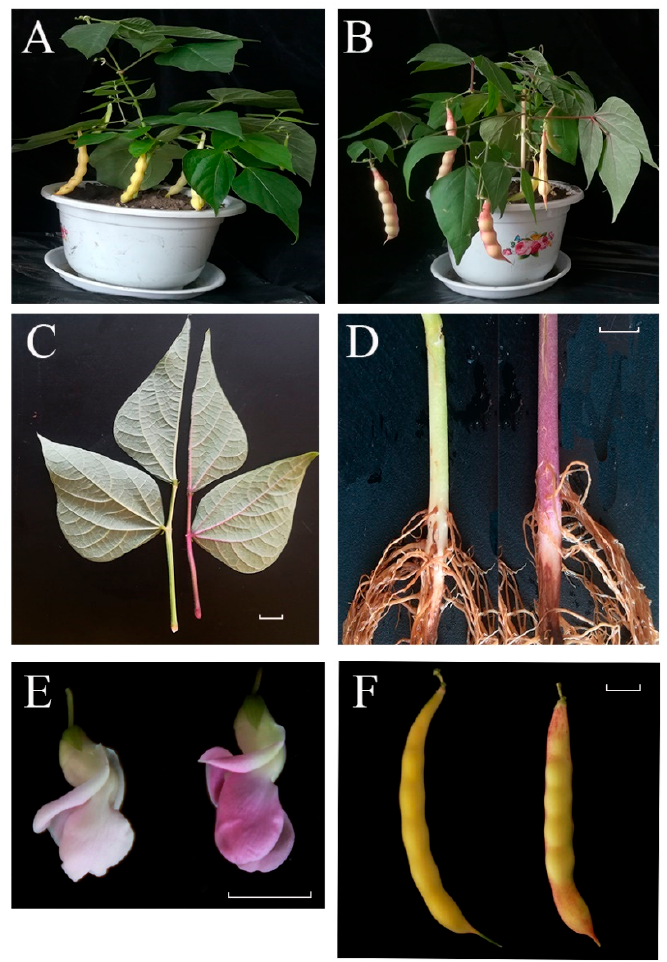
Figure 1. Phenotypic characterization of ‘ pv-pur ’ and wild-type ‘A18-1’. Notes: ( A ): wild type ‘A18-1’ in podding stage; ( B ): purple mutant ‘ pv-pur ’ plant in podding stage; ( C ): leaves and stems of wild type ‘A18-1’ (left) and purple mutant ‘ pv-pur ’ (right); ( D ): hypocotyls of wild type ‘A18-1’ (left) and purple mutant ‘ pv-pur ’ (right); ( E ): flowers of wild type ‘A18-1’ (left) and purple mutant ‘ pv-pur ’(right); ( F ): bean pods of wild type ‘A18-1’ (left) and purple mutant ‘ pv-pur ’ (right). The scale bar is 1 cm.